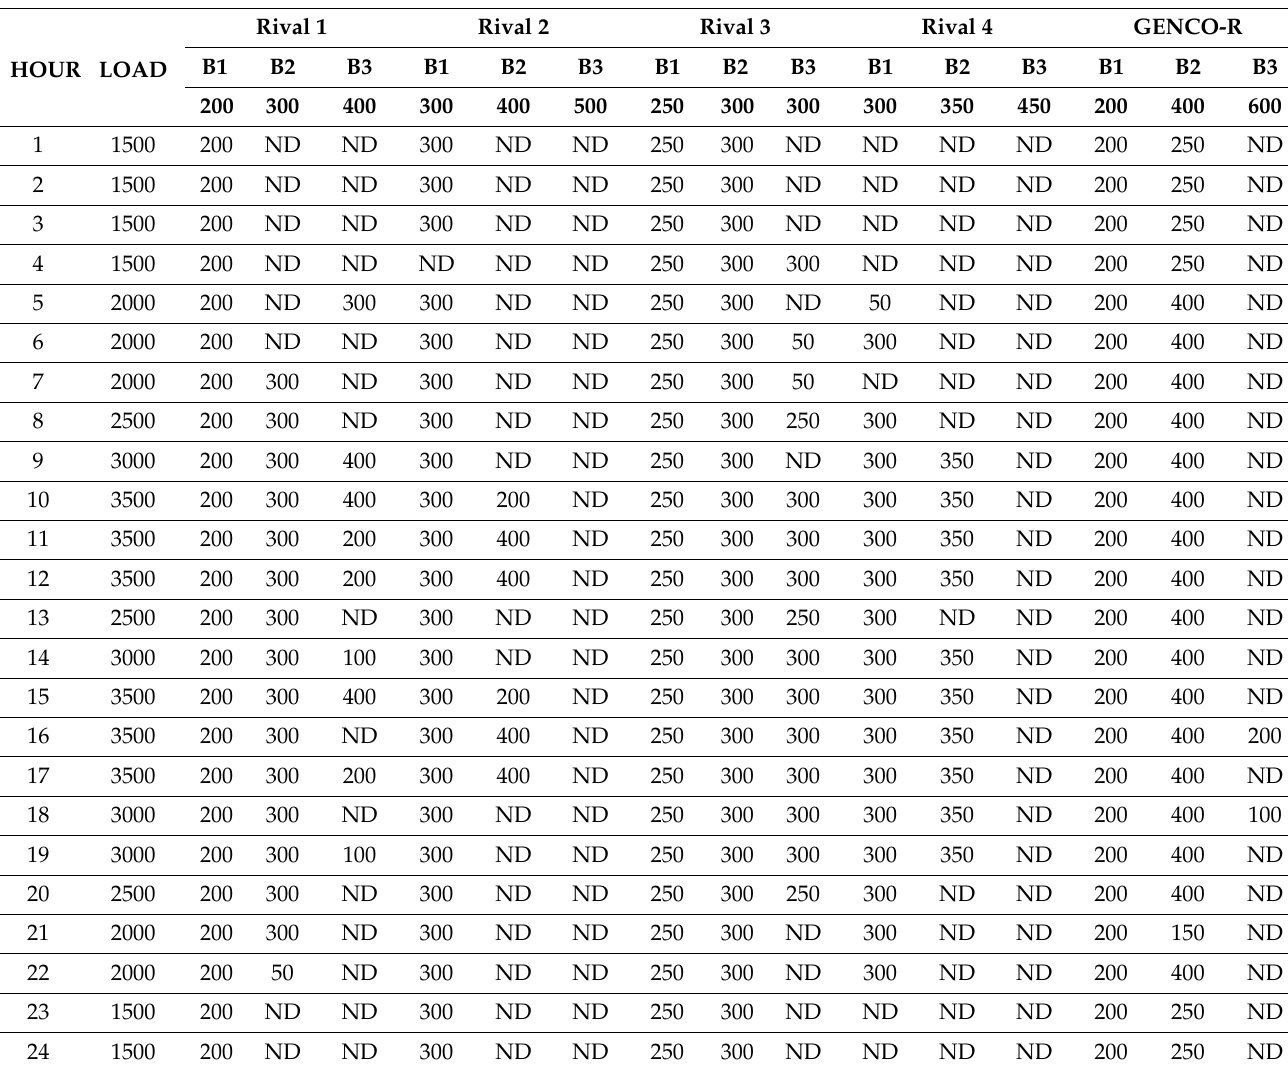
Table 12. Dispatch Obtained by Different Algorithms by using Weibull PDF for